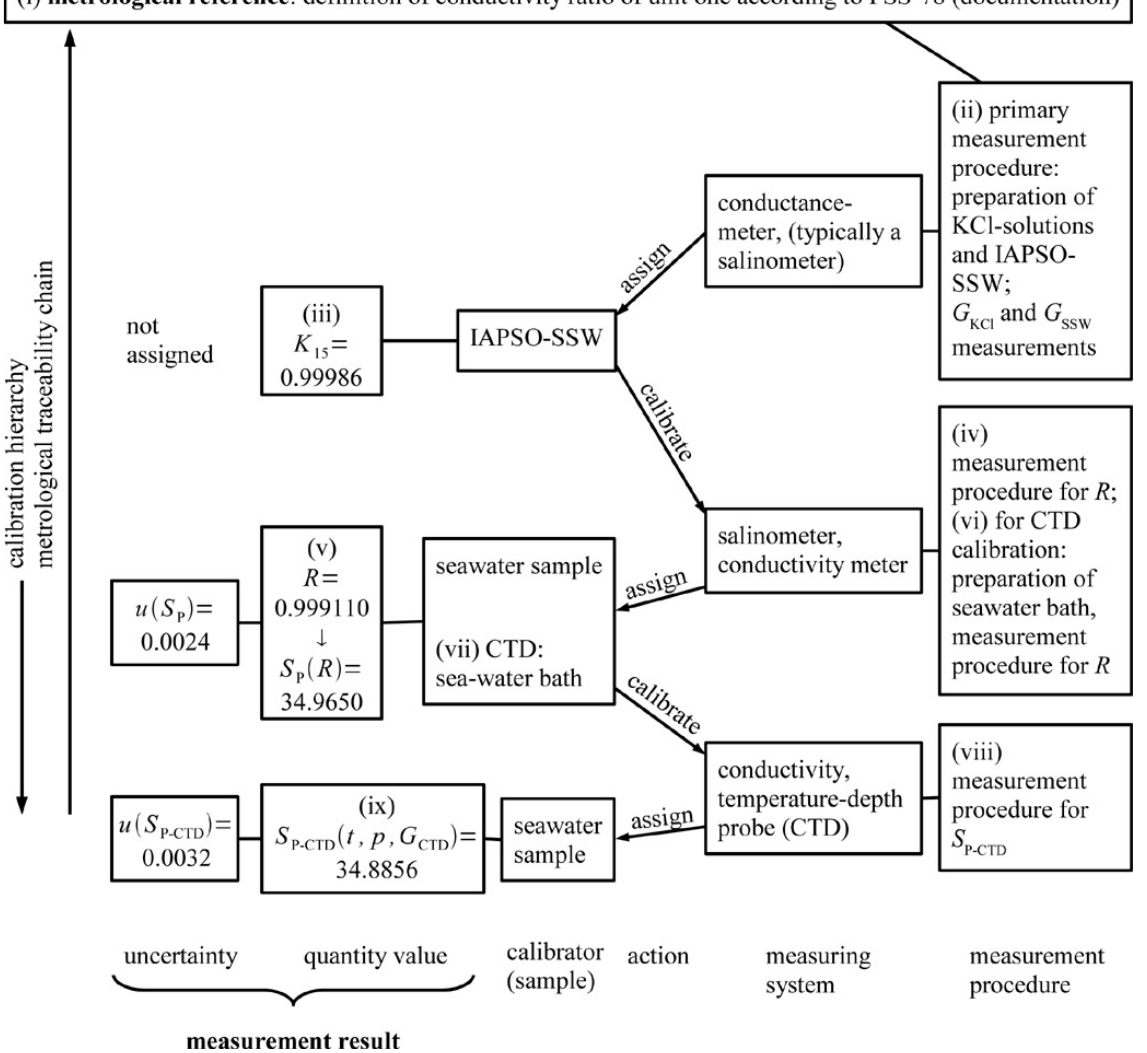
Fig. 1. Illustration of the current traceability of a measured conductivity ratio R and the derived Practical Salinity result S P respectively to the K 15 ratio of Standard Seawater (SSW). Starting from the top of the figure and working towards the bottom, it indicates (i) the metrological reference for conductivity ratio measurements, which is the (standardizing) documentation of PSS-78 (UNESCO, 1981), in particular the definition of the conductivity ratio. This also describes (ii) the procedure how to realize (embody) the (iii) K 15 ratio in IAPSO-SSW. In turn, SSW is used for the calibration of a salinometer. (iv) According to a measurement procedure that is described by the manufacturer, such a calibrated salinometer can then be used to measure the (v) conductivity ratio of a seawater sample, which is finally used to calculate Practical Salinity. Concerning a CTD probe (vi) a procedure is defined to prepare a seawater bath and measure its R value using a calibrated salinometer. This (vii) bath is then used to calibrate a CTD for (ix) Practical Salinity measurements according to (viii) a defined measurement procedure. Each of these steps relies on the previous as part of the calibration hierarchy (far left column) and represents an element of the metrological traceability chain in the reversed order (next to leftmost column). The leftmost column of boxes indicates the typical uncertainties associated with recently calibrated salinometers and CTDs. Note that no uncertainty is attributed to the K 15 value of SSW, however, the uncertainty associated with a salinometer measurement, also accounts for the instability of SSW. The second column of boxes from the left shows typically measured quantity values to which these uncertainties apply, both giving the measurement result. The third column of boxes indicates the sample under consideration for each step in the calibration hierarchy. The column of arrows indicates specific connections in terms of quantity values passed between the levels. An arrow from the right to the left hand side indicates that a measurement procedure (rightmost column of boxes) and measuring systems (next to rightmost column) are used to assign a quantity value (conductivity ratio or Practical Salinity) to a sample. An arrow from the left to the right hand side indicates that a quantity value, which is embodied in a solution, is used to calibrate a measurement